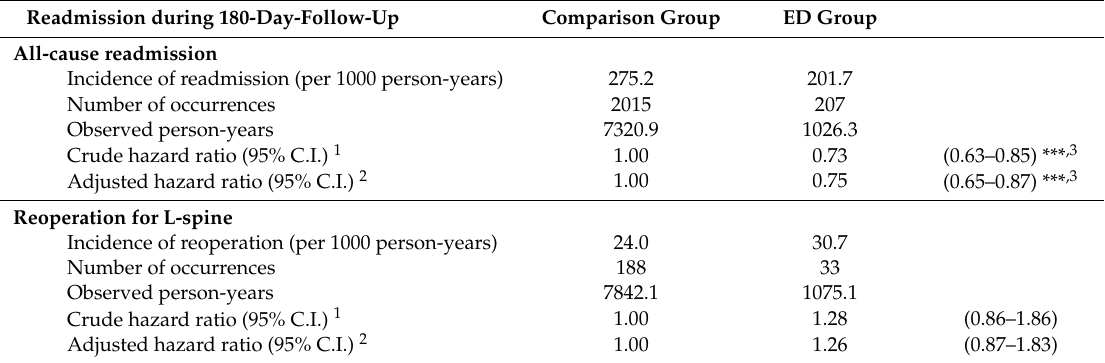
Table 2. All-cause readmission rates and reoperation rates for L-spine during 180 day follow-up